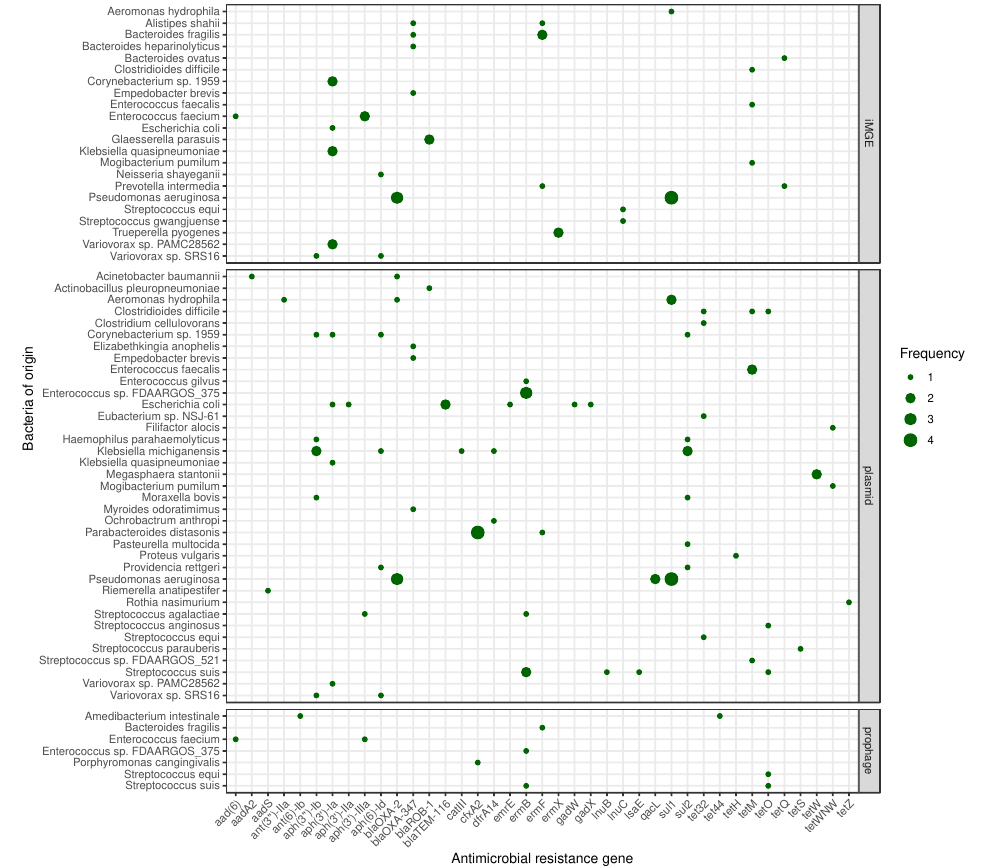
Figure 3. Mobile ARG frequency by bacteria of origin. The size of the dots indicates the occurrence frequency of the given gene flanked by iMGE, positioned in plasmid or